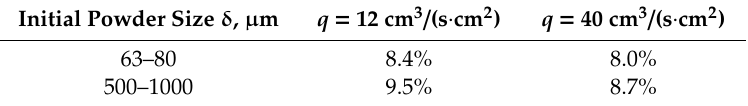
Table 3. E ff ect of flow rate of nitrogen–argon mixture on the nitridation of chromium.